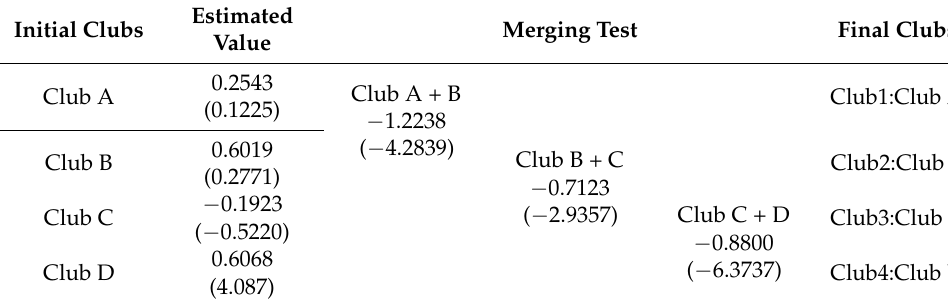
Table 4. Results of convergence test for Chinese provincial clubs.